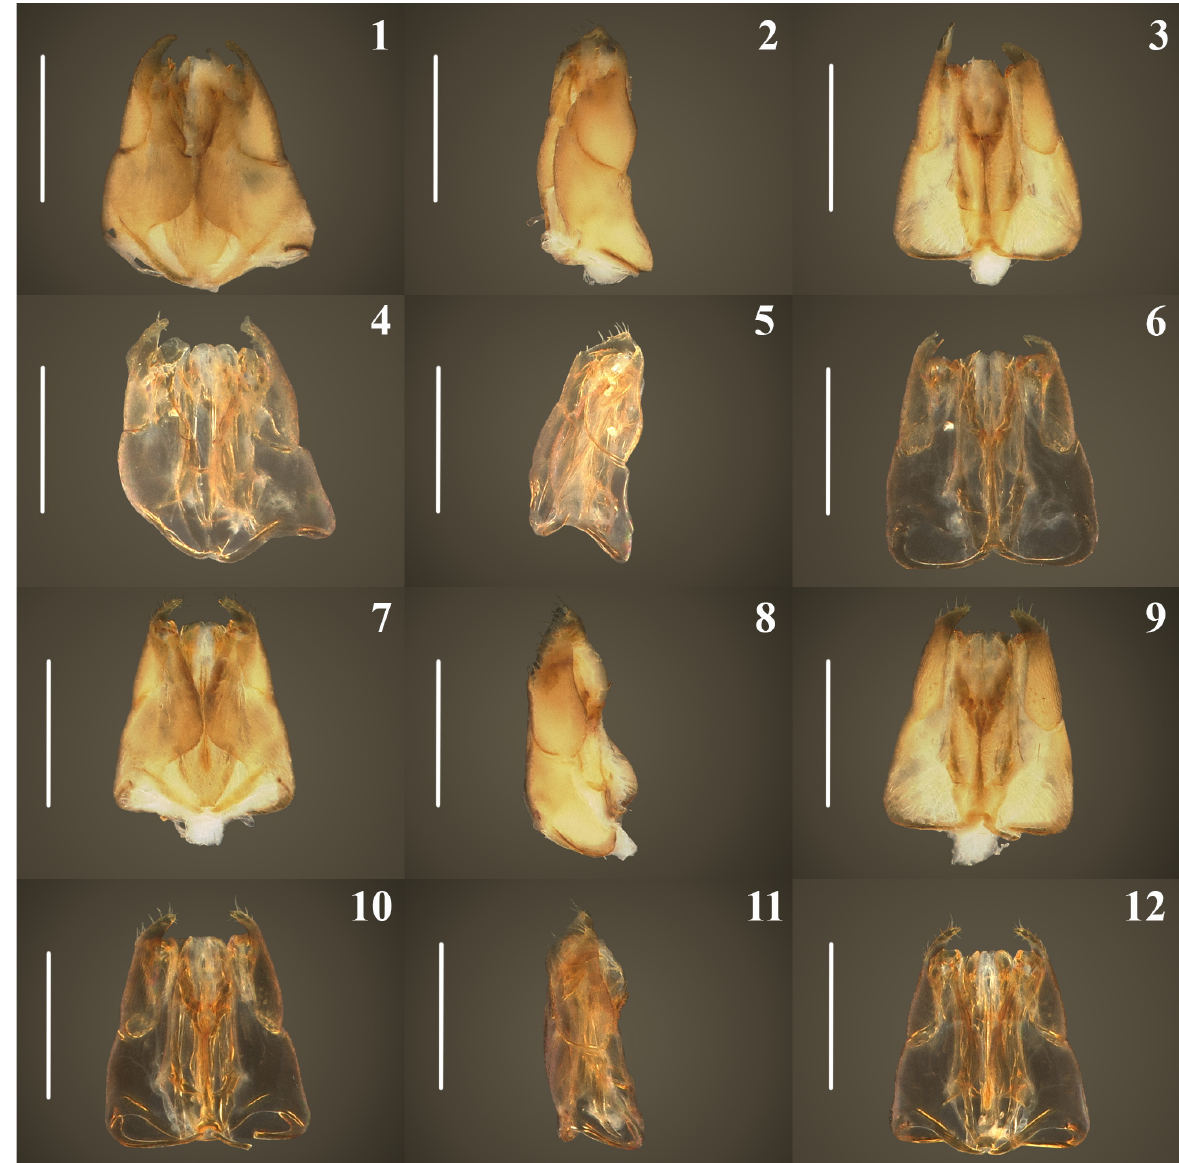
Figures 1-12- Male genital of Dissomphalus sp. Before KOH treatment: 1 . Dorsal view; 2 . Lateral view; 3 . Ventral view. After KOH treatment: 4 . Dorsal view; 5 . Lateral view; 6 . Ventral view. Before Proteinase K treatment: 7 . Dorsal view; 8 . Lateral view; 9 . Ventral view. After Proteinase K treatment: 10 . Dorsal view; 11 . Lateral view; 12 . Ventral view. Scale bars=300